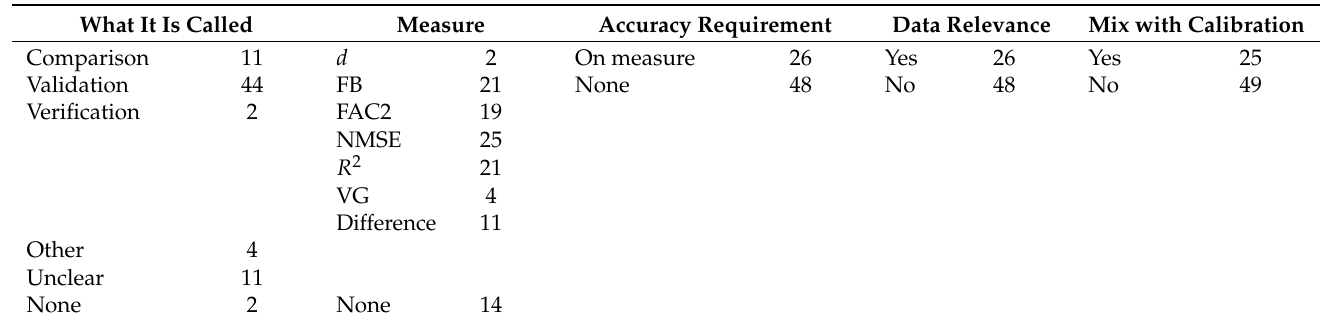
Table 7. Features of validation. The name that different authors give to validation is given in the first column, in alphabetical order, except for the “Other”, “Unclear” and “None”